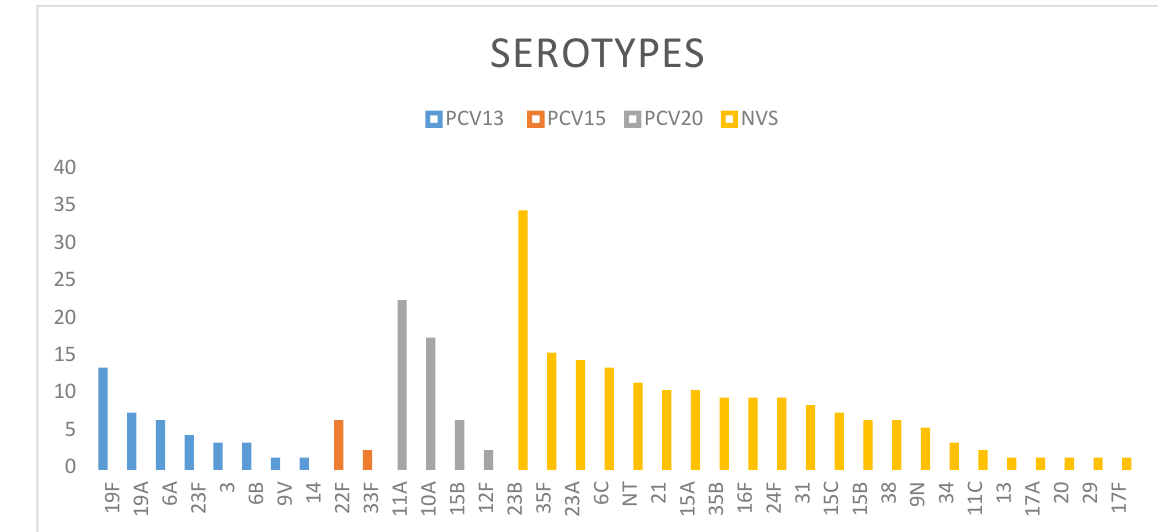
Figure 1. Serotype distribution of nasopharyngeal Streptococcus pneumoniae isolates from healthy children in Murcia. PCV13: pneumococcal conjugate vaccine 13-valent. PCV15: pneumococcal conjugate vaccine 15-valent. PCV20: pneumococcal conjugate vaccine 20-valent. NVS: non-vaccine serotypes. NT: non typeable serotypes.